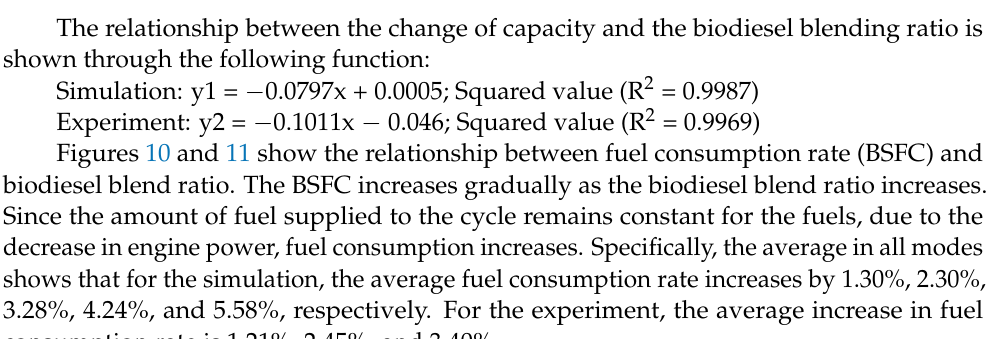
Figure 11. Trend of changing BSFC according to biodiesel blend ratio of simulation (SI) and ex- periment (EX).